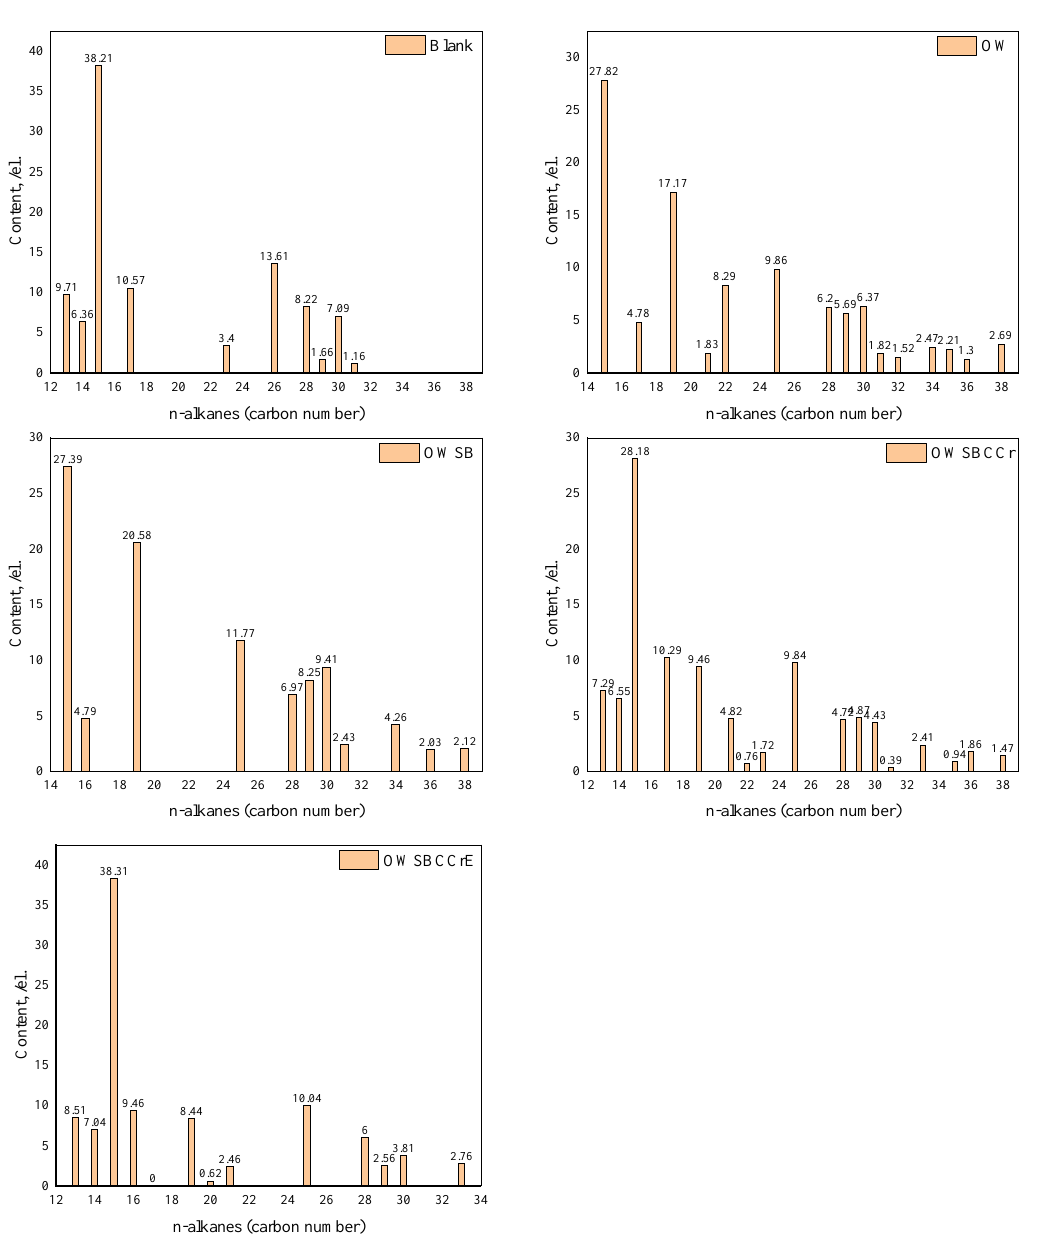
Figure 13. Distributions of saturated hydrocarbons after reaction under different conditions.